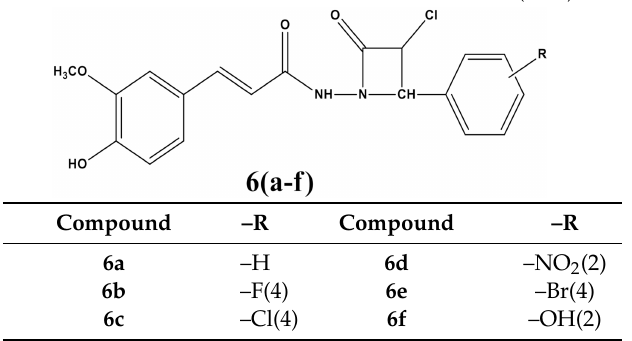
Table 1. Azetidin-2-one derivatives of ferulic acid ( 6a–f